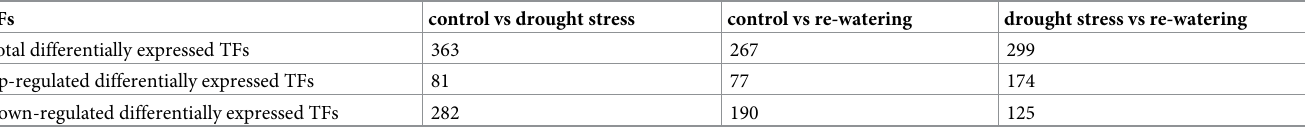
Table 2. Transcription factors (TFs) in the sequencing